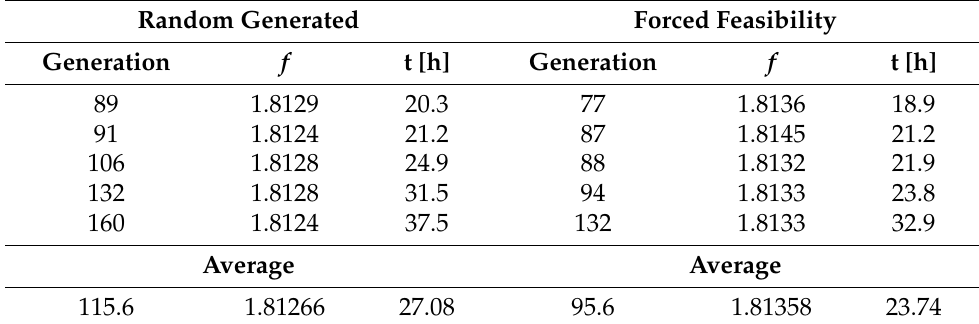
Table 6. Optimization results.